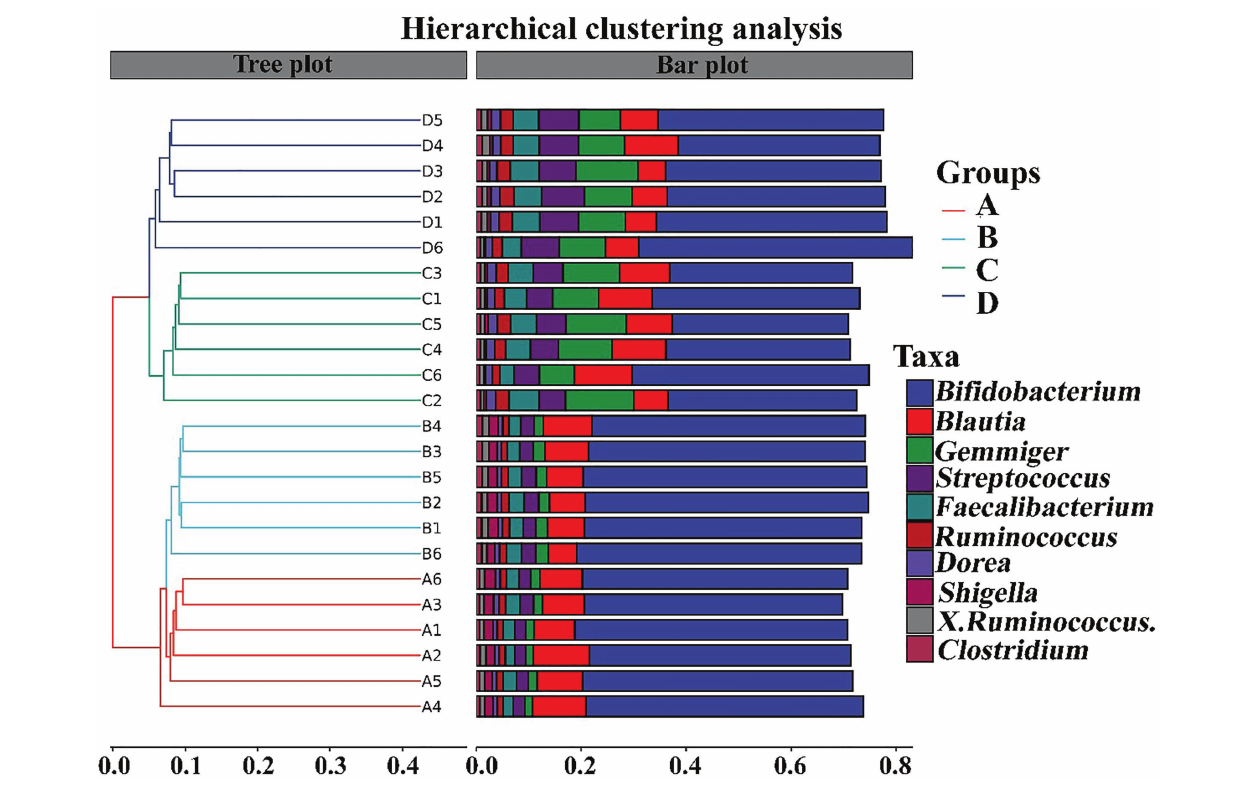
FIGURE 8 | Analysis of hierarchical clustering constructed at the genus level by Bray–Curtis dissimilarity ( n = 6). A: Healthy; B: healthy + ZnONP; C: ADHD; and D: ADHD +